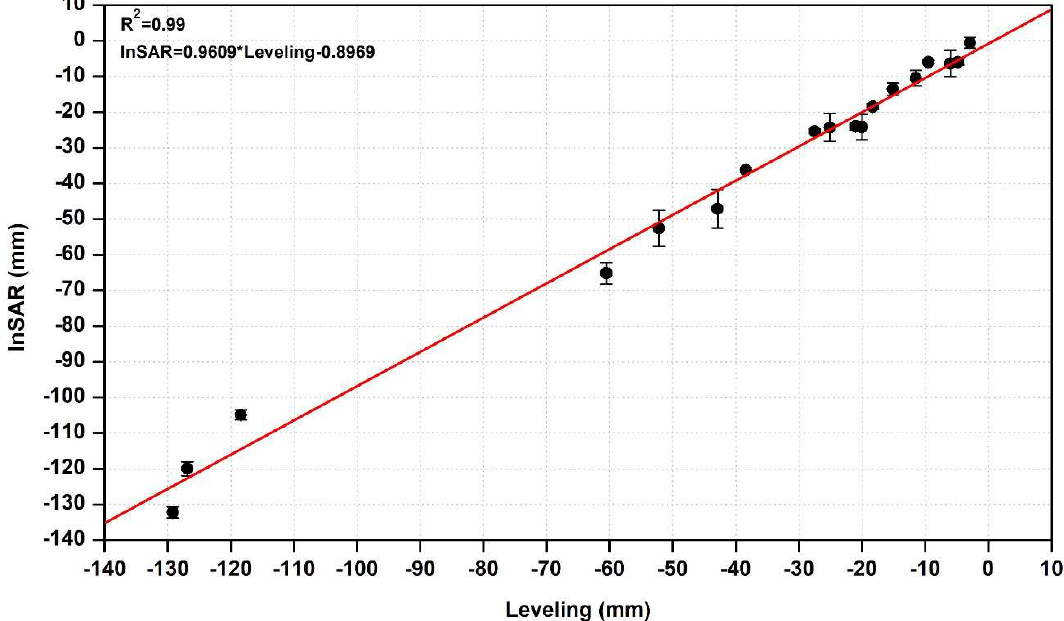
Figure 10. Comparison of InSAR-derived land subsidence and leveling measurements in the year of 2017. Here the point targets within a 50-m radius buffer zone are selected to obtain the corresponding uncertainty of the InSAR-derived deformation. The error bar in each point represents the uncertainty of 1σ.